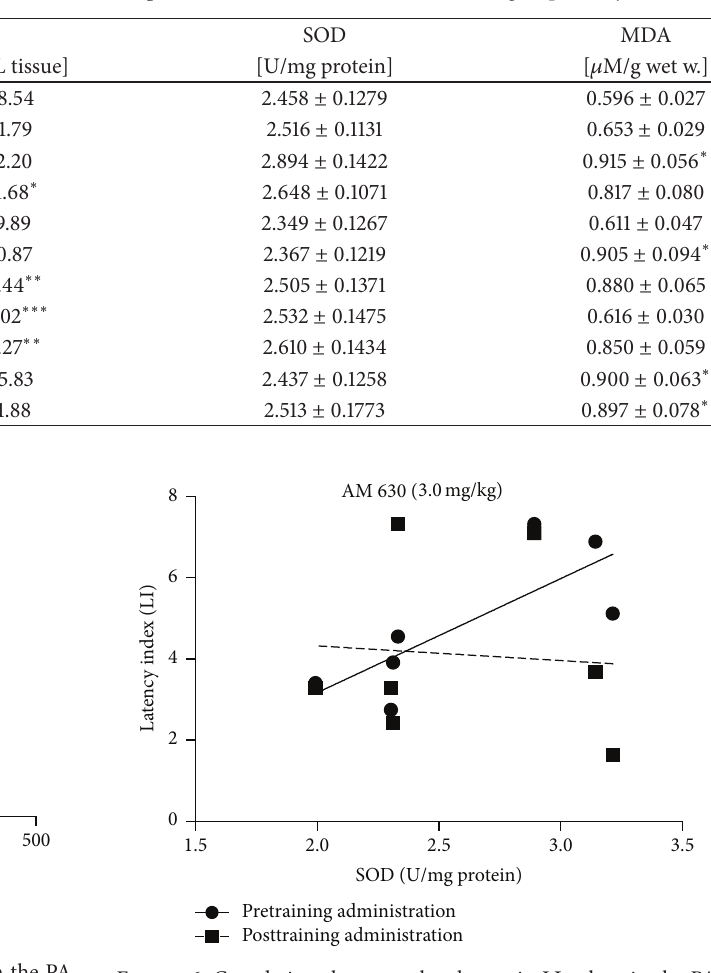
Table 2: Effect of an acute administration of cannabinoid receptor ligands on oxidative stress biomarkers in the whole brains of mice. Data are presented as the means ± SEM; 𝑛 = 8 –12; ∗ 𝑝 < 0.05 , ∗∗ 𝑝 < 0.01 , and ∗∗∗ 𝑝 < 0.001 versus vehicle-treated control group; Tukey’s test.